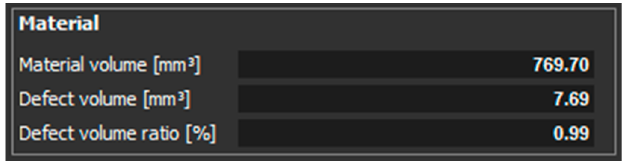
Figure 10. Measured values for a sample with a thickness of 1 mm and oriented XZ.